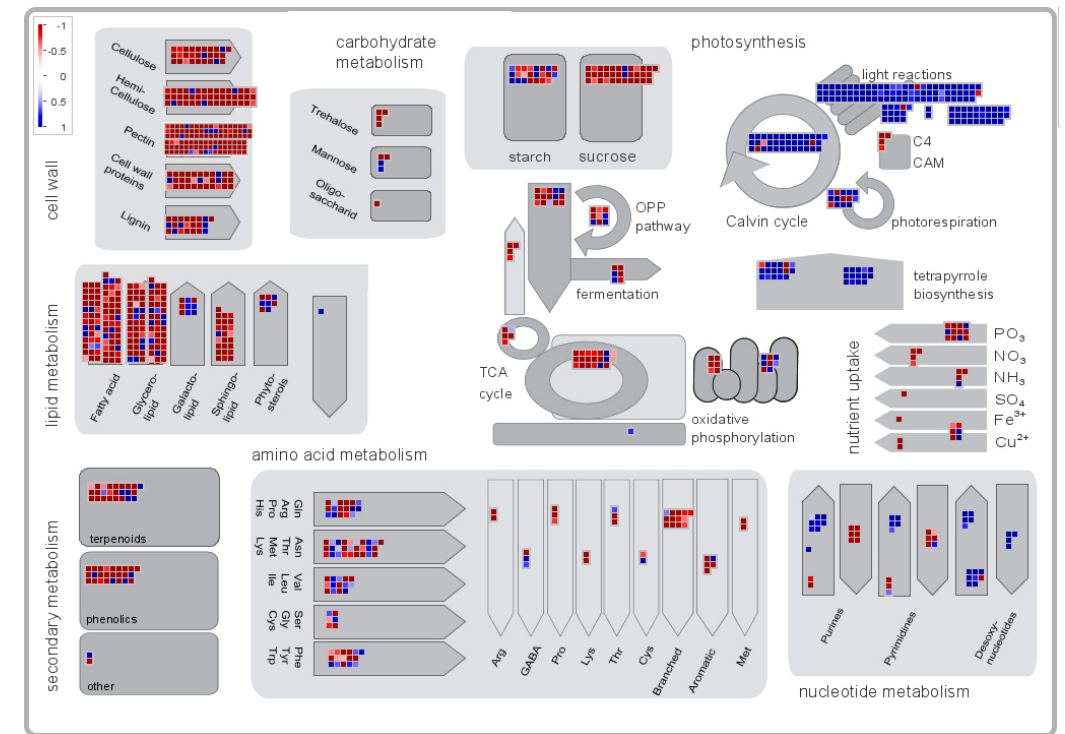
Figure 9. Regulatory overview produced by MapMan software.